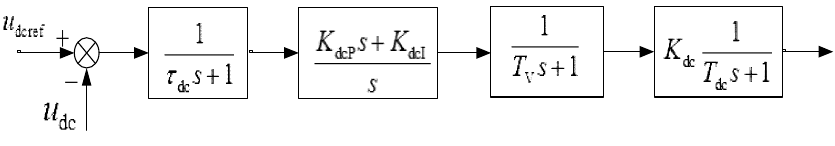
Figure 7. The DC-link bus voltage control diagram of the UPQC.